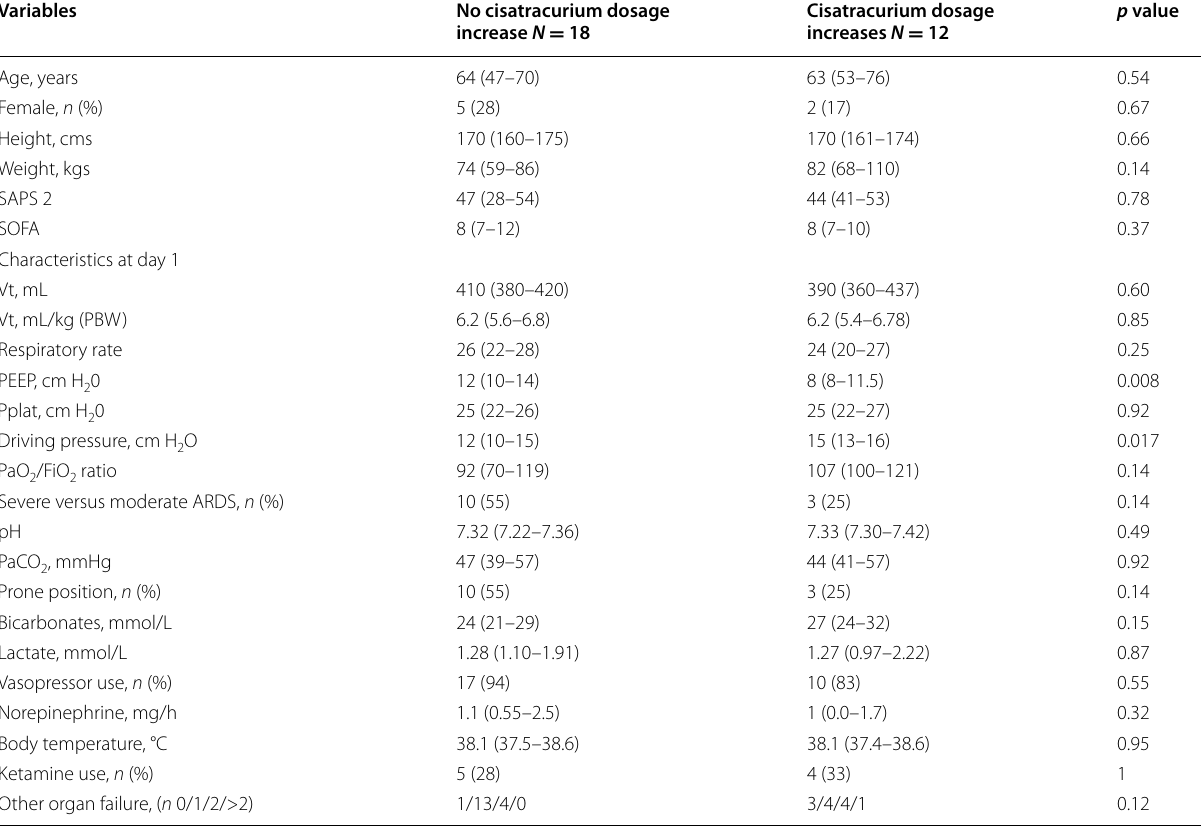
Variables are presented as the median interquartile range. ARDS acute respiratory distress syndrome, PBW predicted body weight, PEEP positive end-expiratory ± pressure, Pplat , end-inspiratory plateau pressure, SAPS 2 Simplified Acute Severity Score 2, SOFA , Sepsis-related Organ Failure Assessment, Vt tidal volume, ARDS